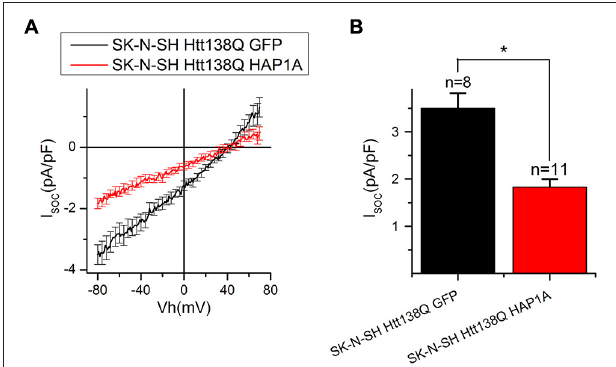
FIGURE 7 | Reduction of thapsigargin-induced Ca 2 + entry in SK-N-SH Htt138Q HAP1A. (A) Average current/voltage relationships (I/V curves) for currents that were evoked by passive Ca 2 + store depletion with 1 µ M thapsigargin in SK-N-SH Htt138Q cotransfected with GFP (black curve) or HAP1A (red curve). The number of experiments is shown in (B) above the bars. (B) Average amplitudes of thapsigargin-induced currents in SK-N-SH Htt138Q cotransfected with GFP (black bar) or HAP1A (red bar). Current amplitudes were determined at a test potential of − 80 mV and plotted as mean ± SEM. ∗ p < 0.05, significant difference in current